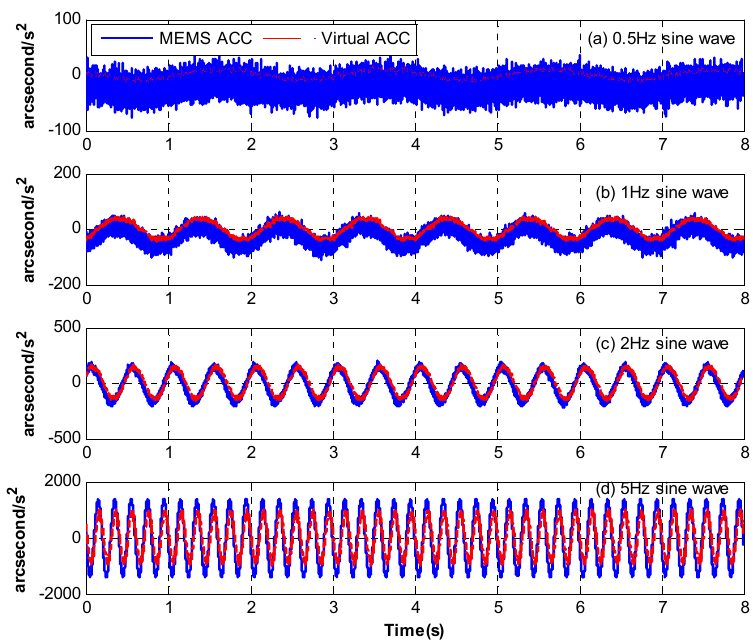
Figure 7. The time-domain curves of the MEMS accelerometer and the virtual accelerometer.